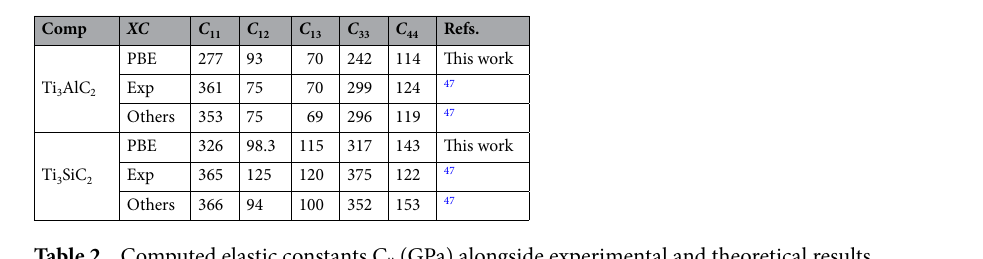
Table 2. Computed elastic constants C ij (GPa) alongside experimental and theoretical